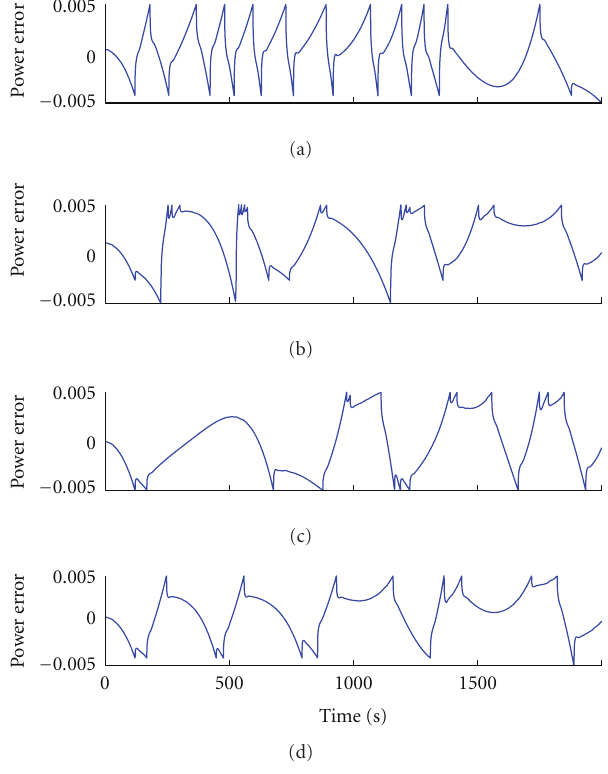
Figure 12: Actual relative neutronic power error versus time at full power. Illustration of the e ff ects of proposed changes in the control logic to reduce the control rods movements rate. (a) Original control design. (b) Time delay inserted in the rod set point generator. (c) Delay inserted and azimuthal power distribution control suppresed. (d) Modified time delay and azimuthal power distribution